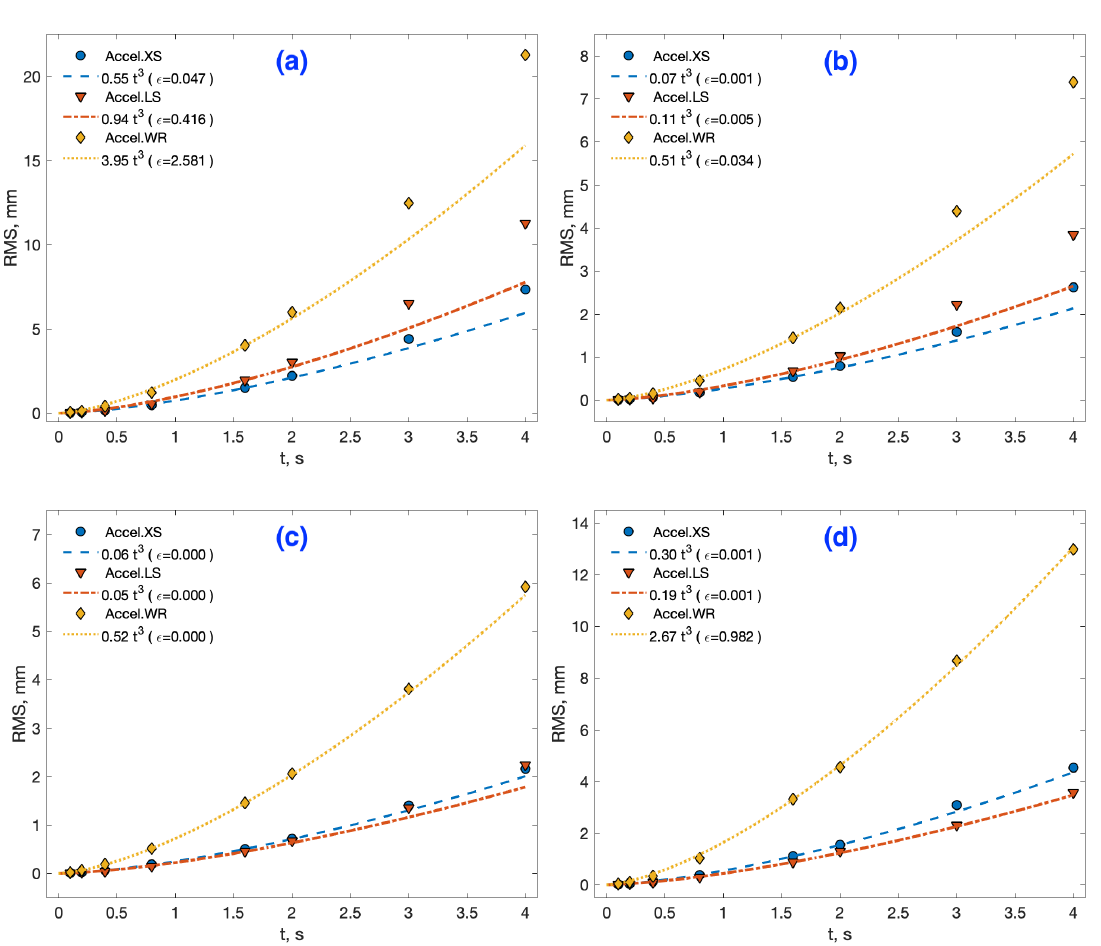
Figure 4. Static RMS distance estimation errors for each sensor (markers) and its cubic polynomial model (lines). ( a ) The CMS method. ( b ) The LRI method. ( c ) The MSI and OFI methods. ( d ) The DDI method. The model fitness is evaluated with statistic (cid:101) (mm, in